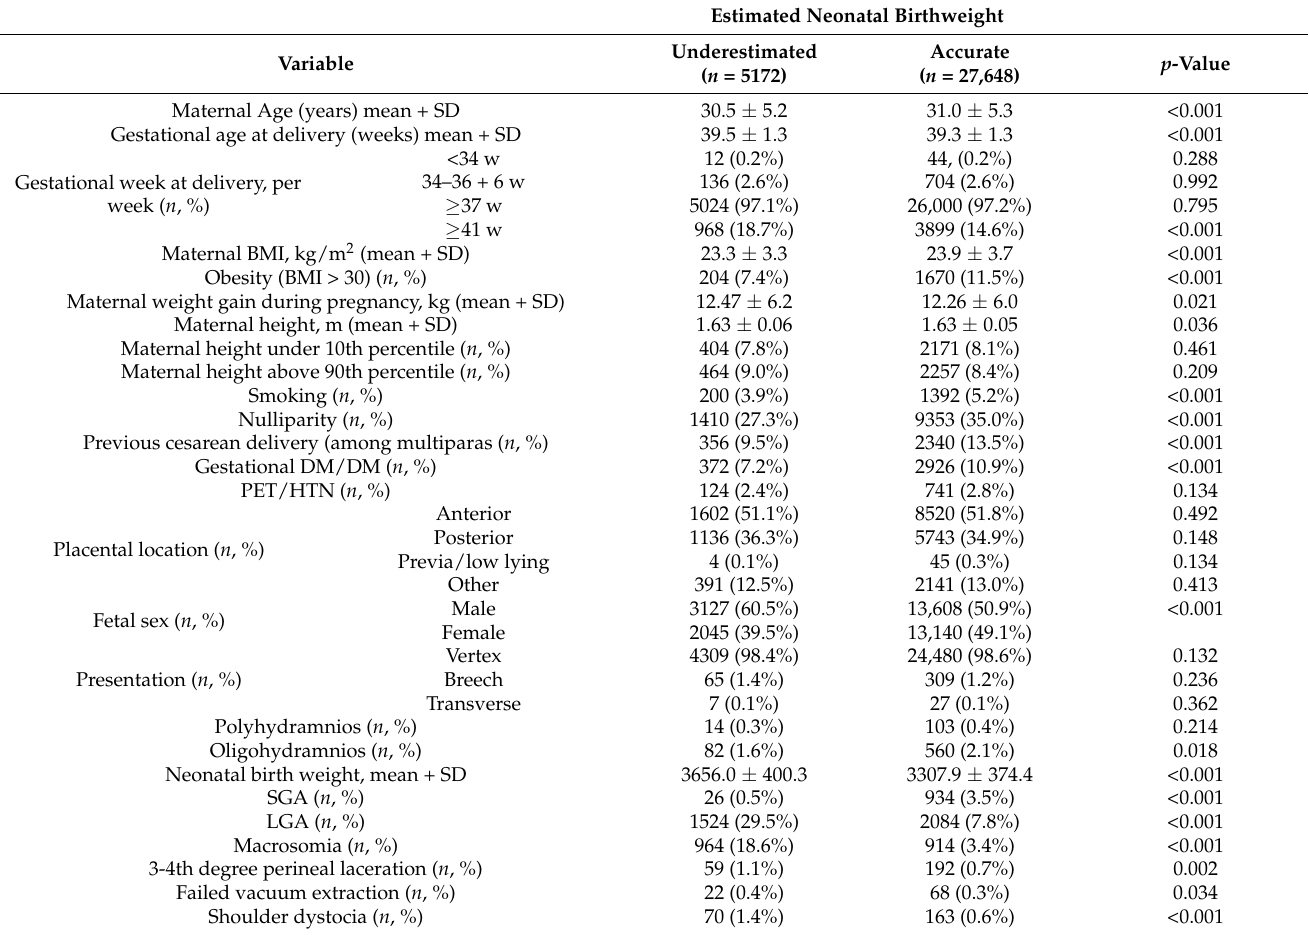
Table 2. Maternal, delivery and neonatal characteristics of the underestimation group compared to the accurate EFW